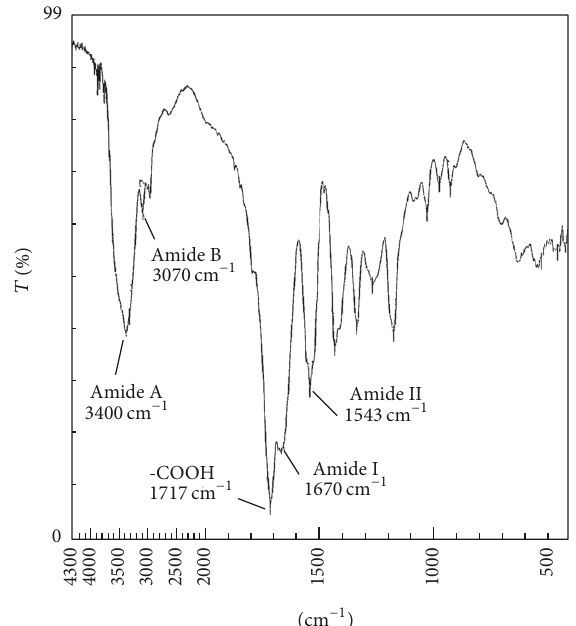
Figure 10: IR spectrum of the higher molecular weight fraction of the reaction mixture obtained from Boc-Gly-L-Asp at 130 ∘ C for 8 h.